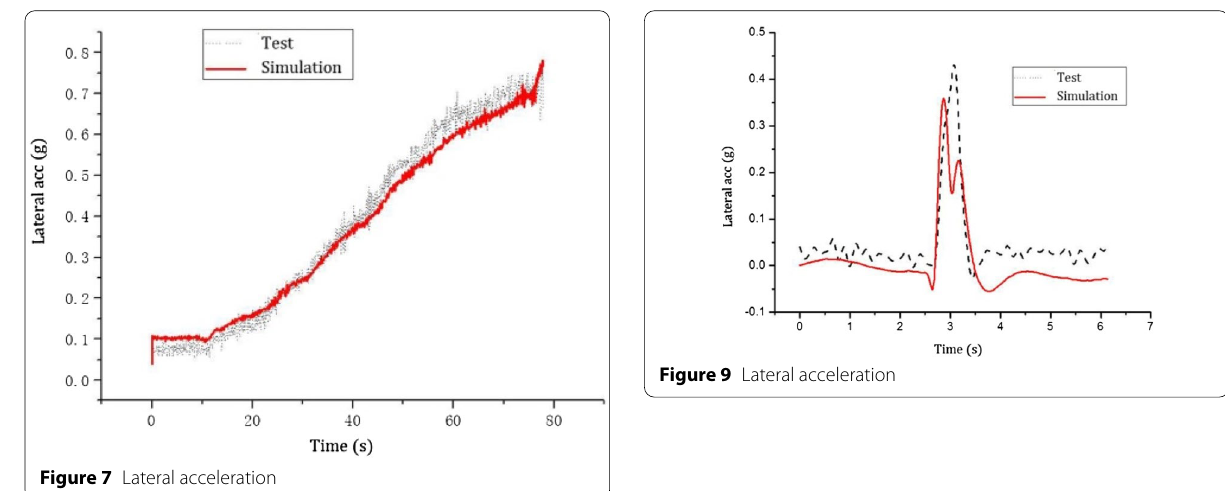
Figure 7 Lateral acceleration